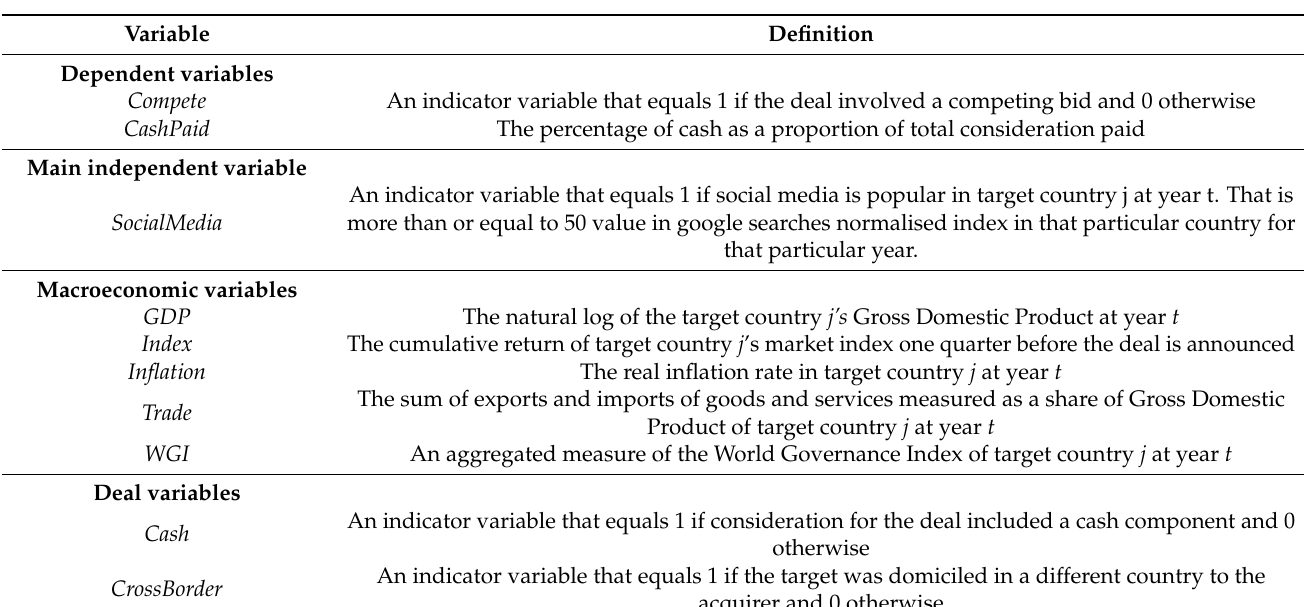
Table A6. This table lists the variable descriptions used in the study.